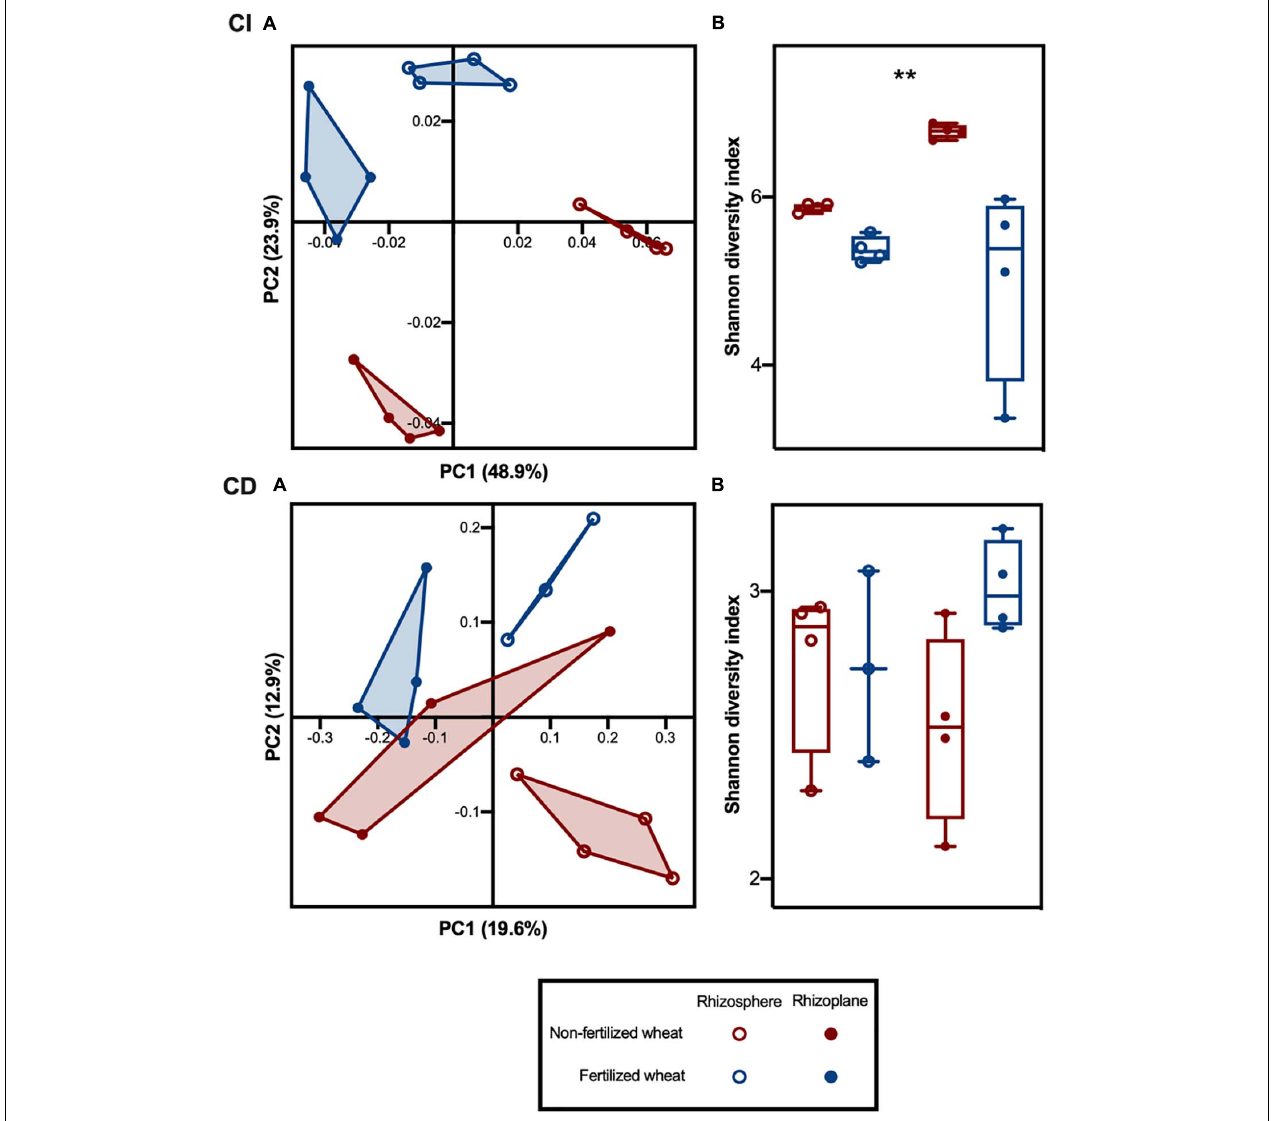
FIGURE 2 | Culture-independent (CI) and culture-dependent (CD) bacterial community diversity in the rhizosphere and rhizoplane of wheat grown in soils with and without fertilizer addition. (A) PCoA plots of bacterial composition based on weighted UniFrac distances for CI and CD communities at ASV level. The percentage shown in each axis corresponds to the proportion of variation explained. (B) Alpha diversity estimates at ASV level for rhizosphere and rhizoplane bacterial communities in non-fertilized and fertilized wheat; with median (line) and hinges at first and third quartiles (25th and 75th percentiles). Significant differences as determined by two-way type III ANOVA are shown by “**” for p < 0.01 between treatment groups. Symbols represent rhizosphere (open circles) and rhizoplane (closed circles) samples from non-fertilized (red) and fertilized (blue) wheat.